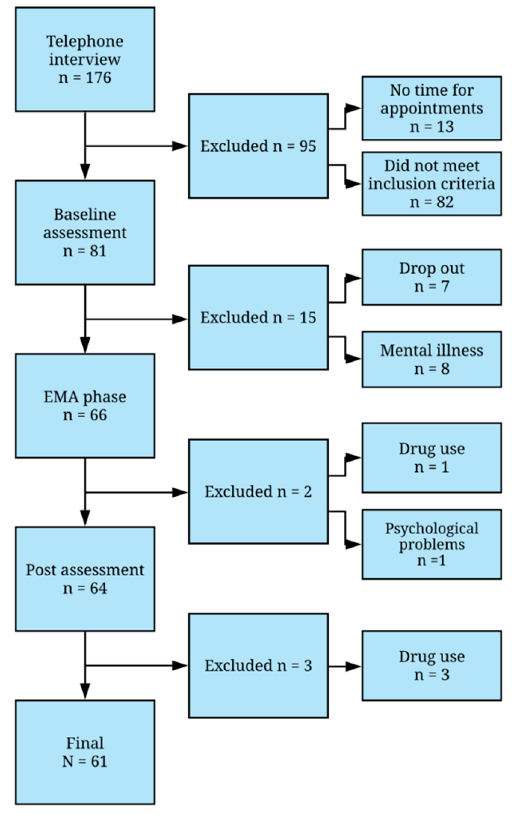
Figure 1. Flowchart of study inclusion. EMA = ecological momentary assessment.